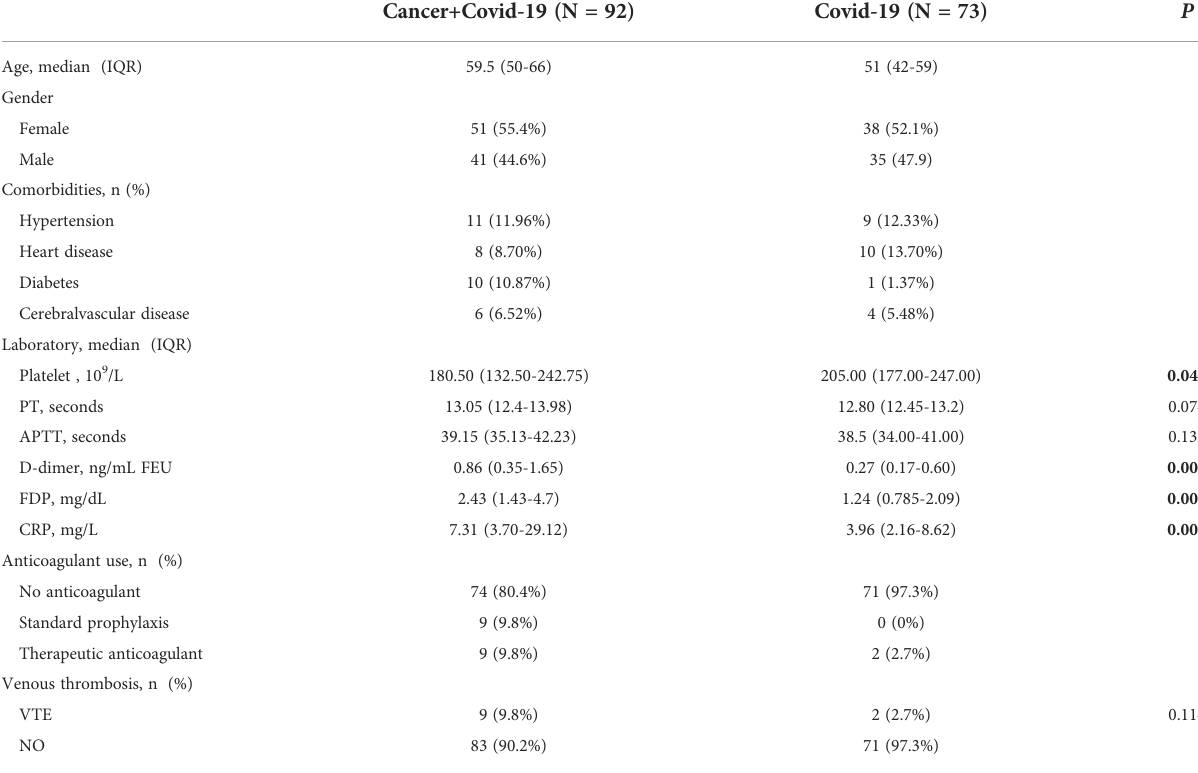
TABLE 1 Baseline characteristics and VTE of cancer patients with COVID-19 and COVID-19